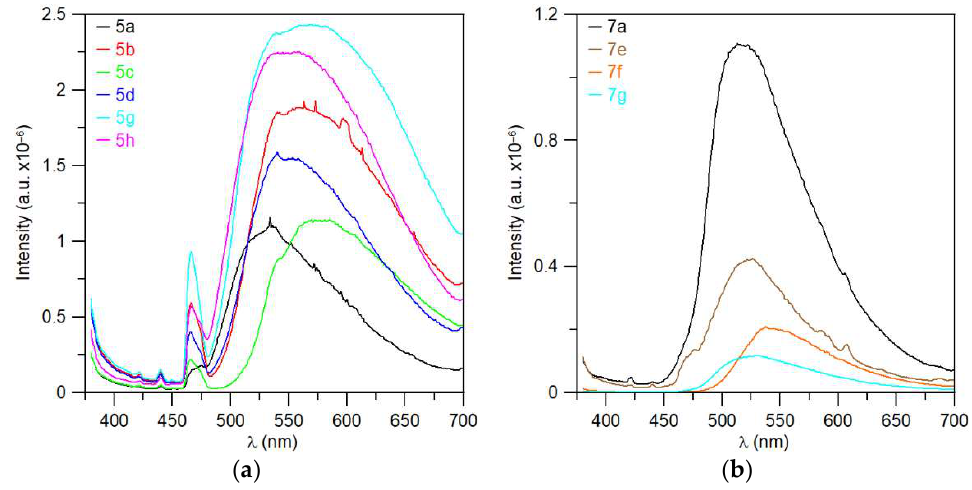
Figure 15. Fluorescence spectrum: ( a ) triazaborines 5a – d , 5g , and 5h ; and ( b ) diazaborinones 7a , 7f – g .